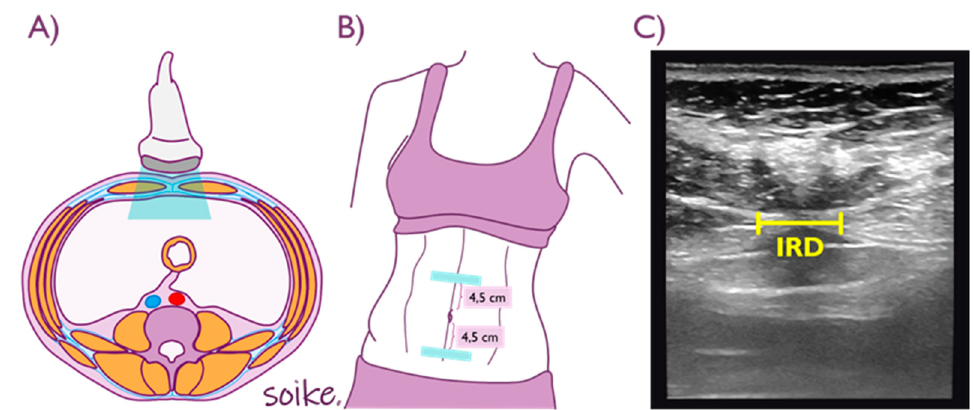
Figure 2. IRD assessment procedure. ( A , B ) Probe positioning. ( C ) Ultrasound image Source: Elena Castellanos López (AKA Soike).